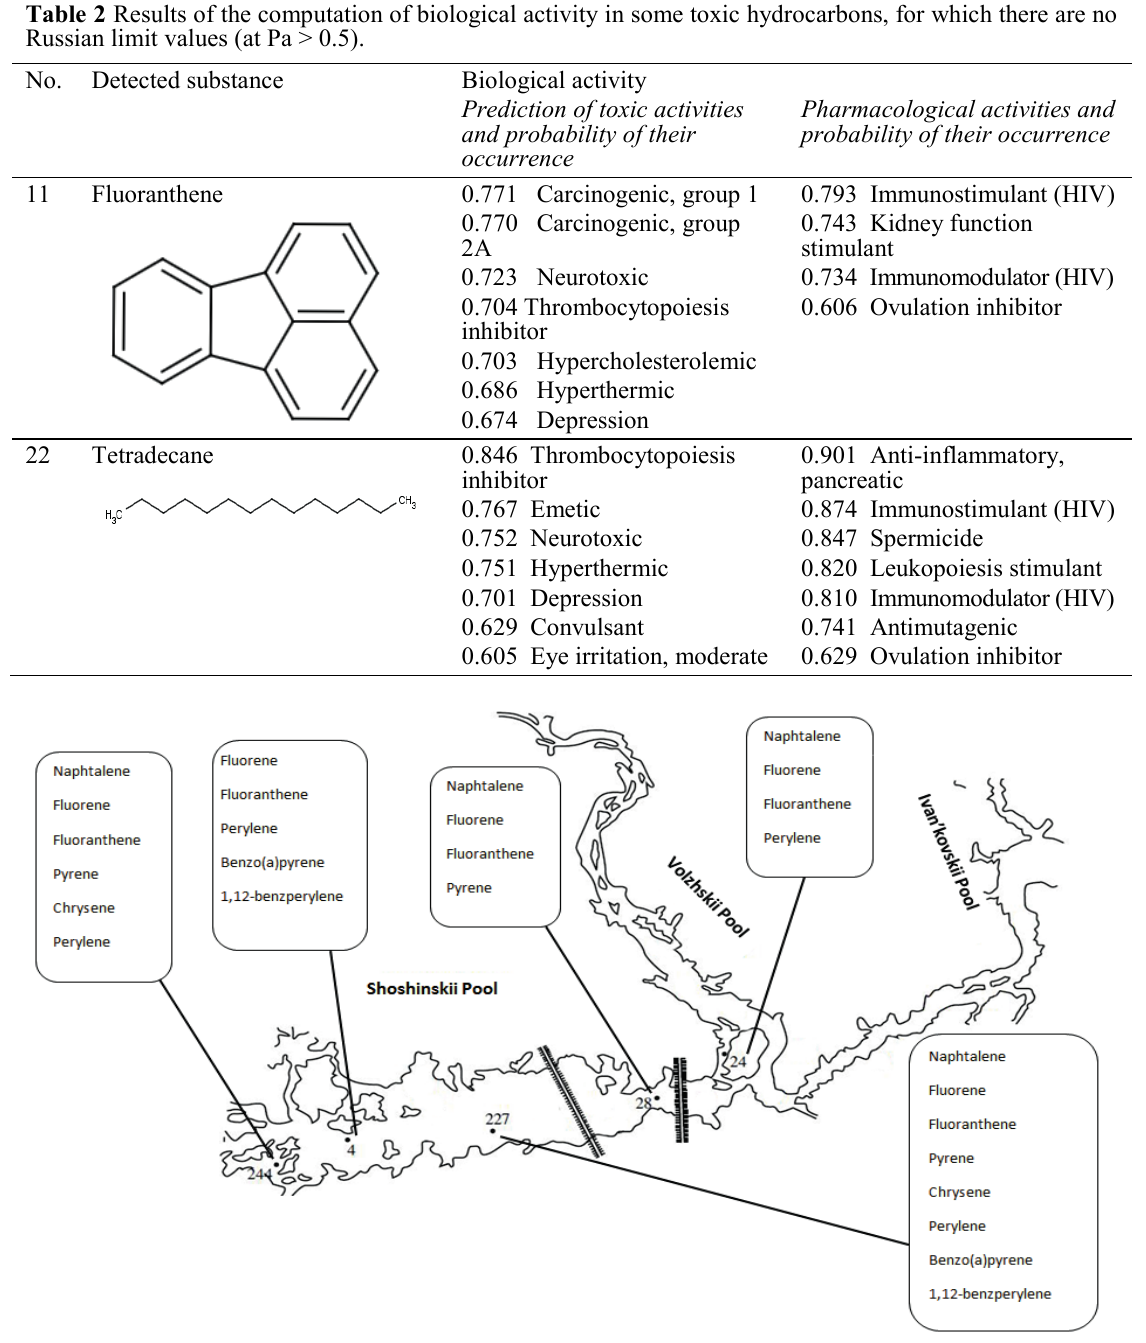
Fig. 3 Distribution of some PAHs in bottom sediments of Ivankovo Reservoir (on stations of sampling) (Nemirovskaya et al .